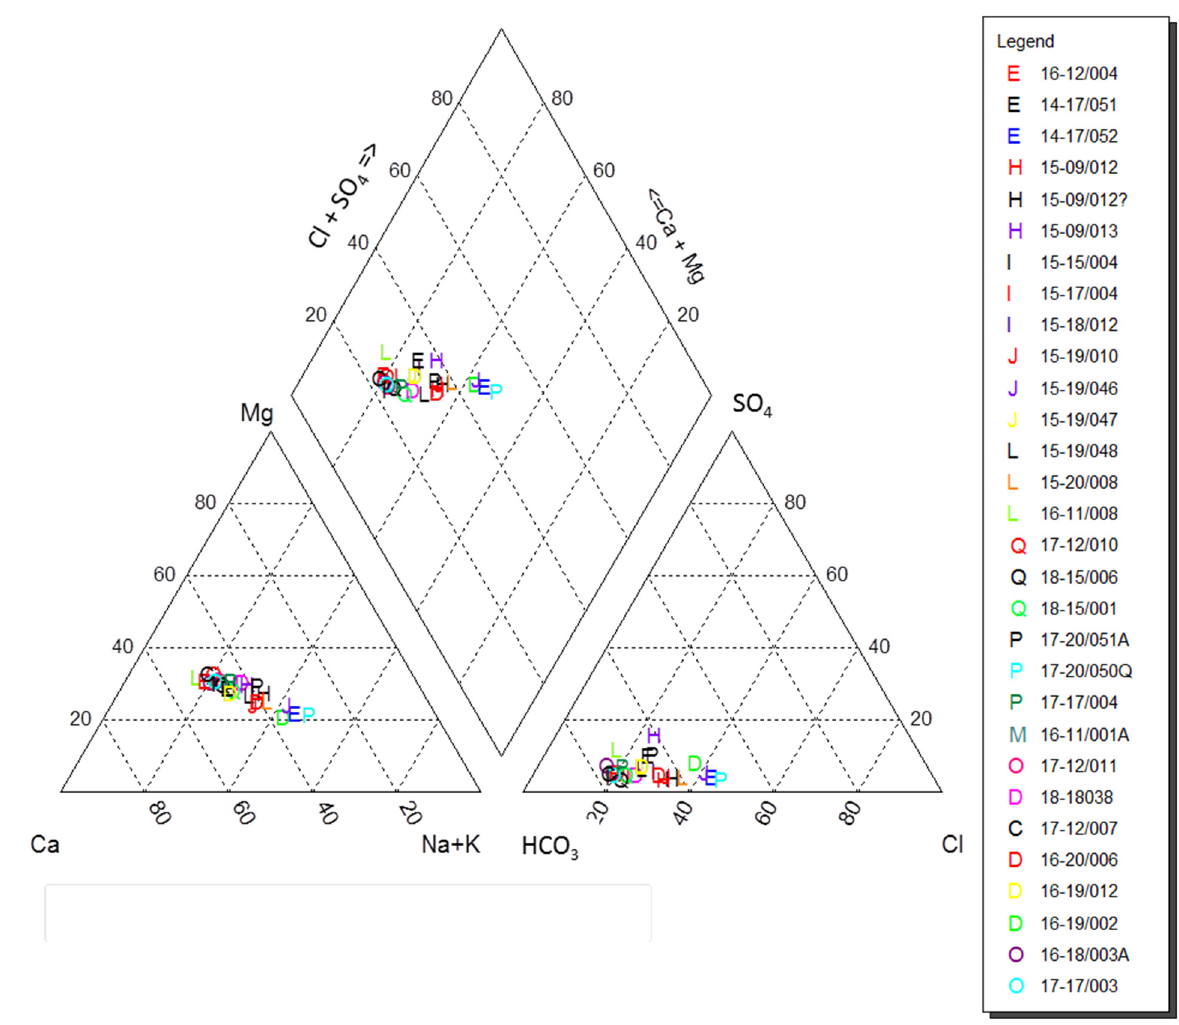
Figure 5. Piper diagram for domestic wells included in the study, tapping the mountain aquifer in the West Bank/Palestine (Legend stands for a well ID).